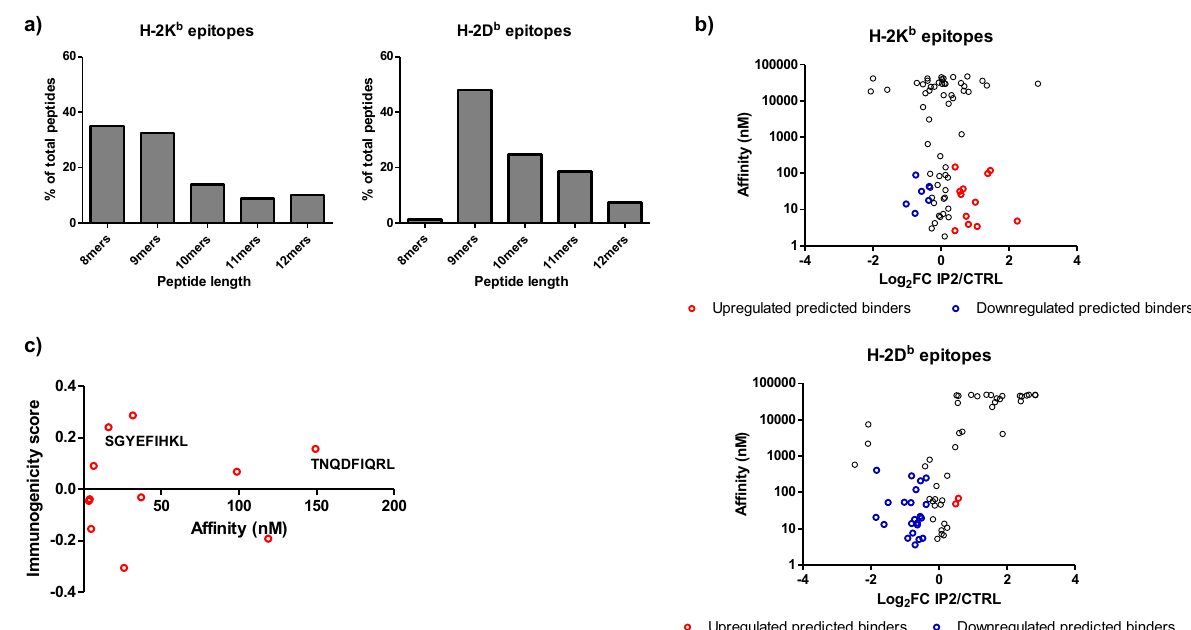
Fig. 5 IP2 alters the MHC-I immunopeptidome of tumor cells. a Length distribution of epitopes identi fi ed at the surface of MCA205 cells in H-2K b molecules (left panel) and H-2D b molecules (right panel) after immunoprecipitation. b Af fi nity for MHC-I molecules of peptides identi fi ed after H-2K b immunoprecipitation (upper panel) and H-2D b immunoprecipitation (lower panel). Red dots represent the predicted binders (af fi nity < 500 nM) displaying a fold change above 1.2 between IP2-treated vs untreated replicates. Blue dots represent the predicted binders (af fi nity < 500 nM) displaying a fold change lower than 0.8 between IP2-treated vs untreated replicates. c Computed immunogenicity score of predicted binders of H-2K b molecules upregulated after treatment with IP2. Epitopes were labelled if the immunogenicity score was above 0.1 and their presence validated in at least two out of three